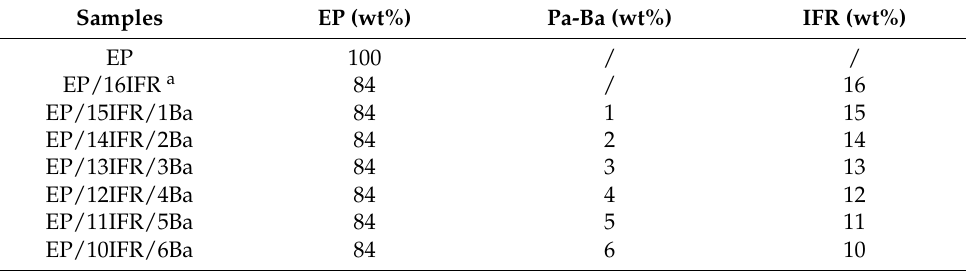
Table 1. The formulations of flame retarded